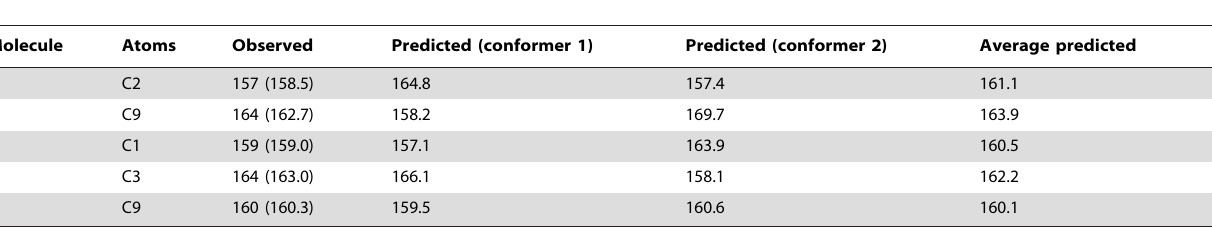
Table 2. Observed and predicted 1 J CH couplings for 1- and 2-napthaldehyde in the conformers shown in Figure 3.